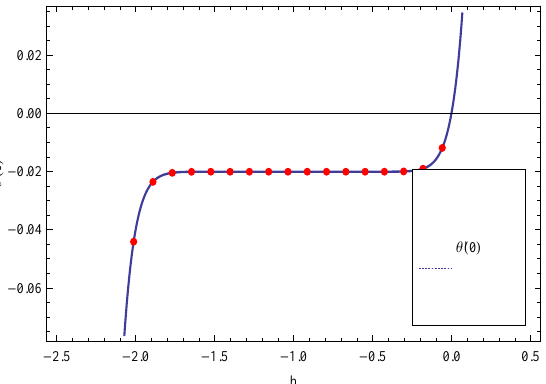
Figure 26. Depicts h curves of f (cid:48)(cid:48) ( 0 ) , when λ = 0.9,kr = 0.9,Pr = 0.5,Ec = 0.5,Nb = 0.5, Nt = 0.6, β = 1 and Sc = 0.6.